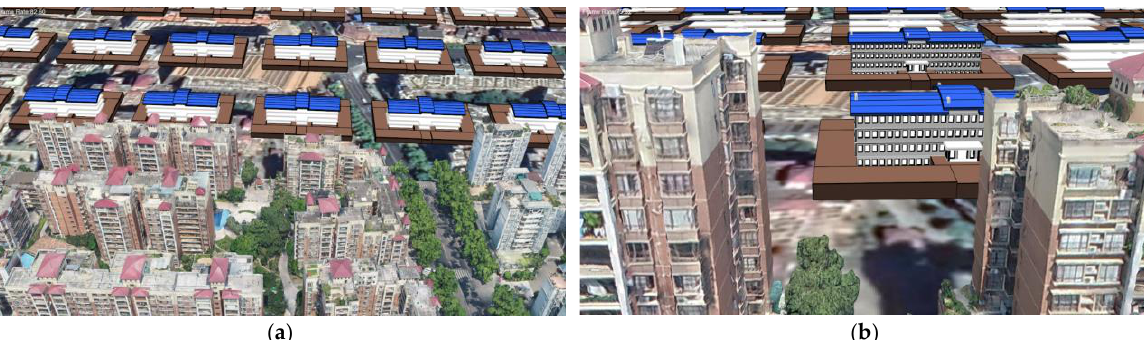
Figure 8. Average frames per second (FPS) for cyan area and red area.